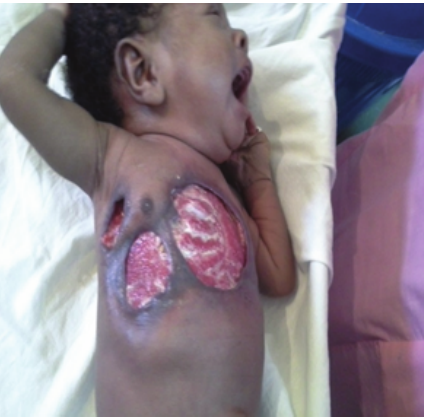
Figure 1: Immediate post-op.